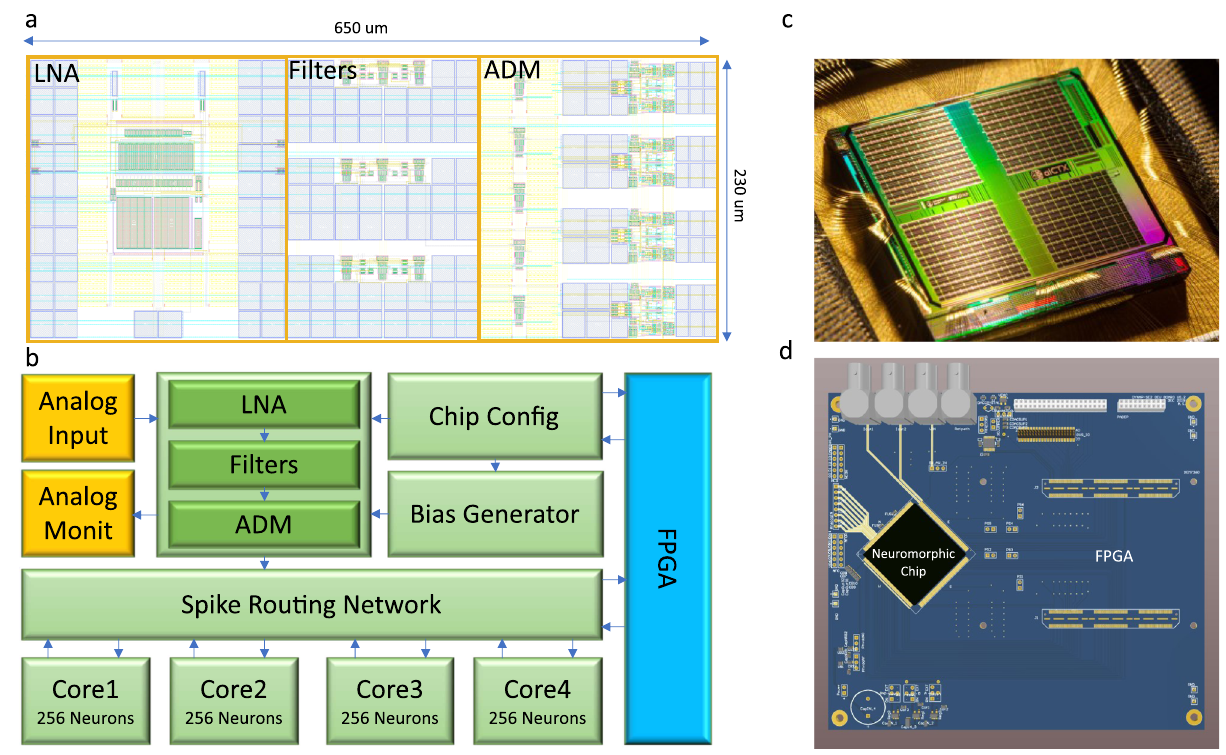
Fig. 2 Neuromorphic electronic system overview. a Physical layout of a single channel of the analog headstage array, including the LNA, three low-pass/ band-pass fi lters, and four ADM signal to spike encoders. b Reduced block diagram of the neuromorphic platform. Analog signals from electrodes are fed into the input headstage that converts them into spike trains and sends them to the SNN implemented on the multi-neuron cores, via a spike routing network. The spike routing network routes the spikes within on-chip SNN and to an external FPGA device used for data logging and prototyping. The FPGA is also used for setting circuit parameters. c Chip photograph showing the 11 mm x 9 mm silicon die. d Prototyping Printed Circuit Board (PCB) used to host the chip and the infrastructure to implement the test setup. The setup is composed of a prototyping FPGA board mounted on the same PCB that hosts the chip, and of probe points to evaluate the characteristics of both input headstage and SNN multi-core